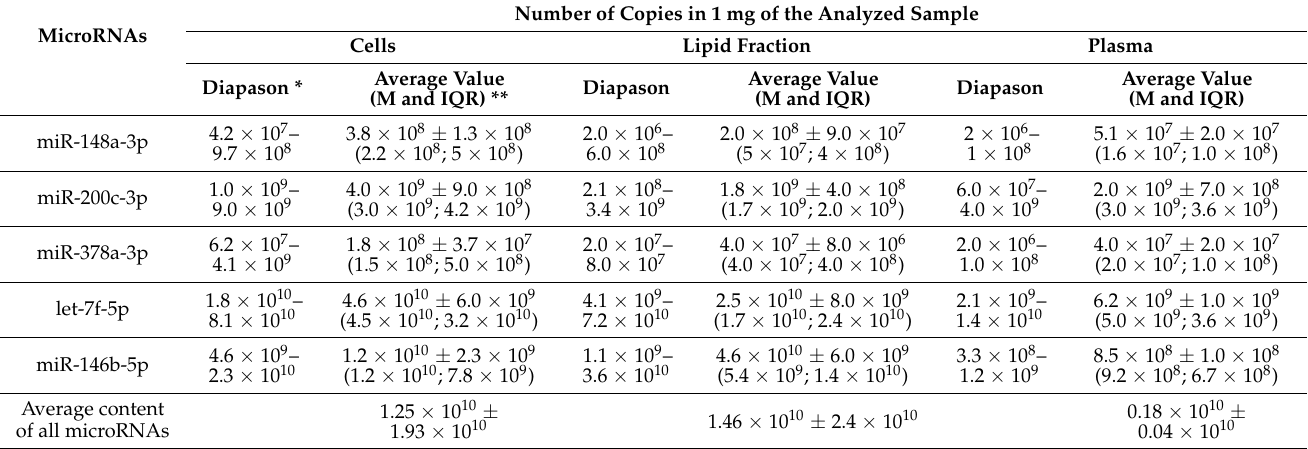
Table 2. Values of relative content of five microRNAs in different fractions of human